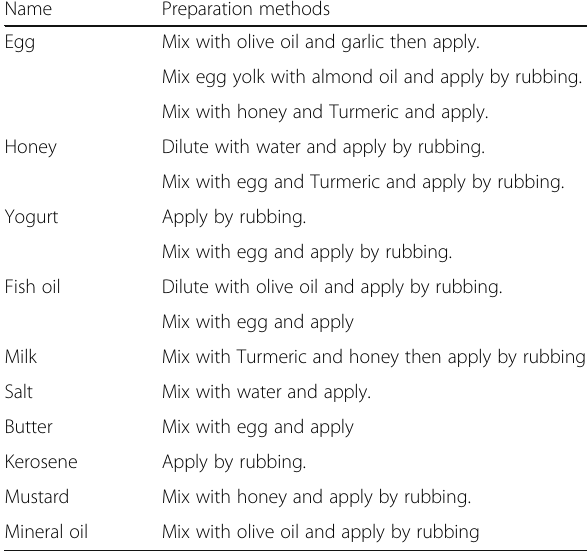
Table 8 Factor of informant ’ s consensus (F ic ) for minerals and animals products, categorized by the types of